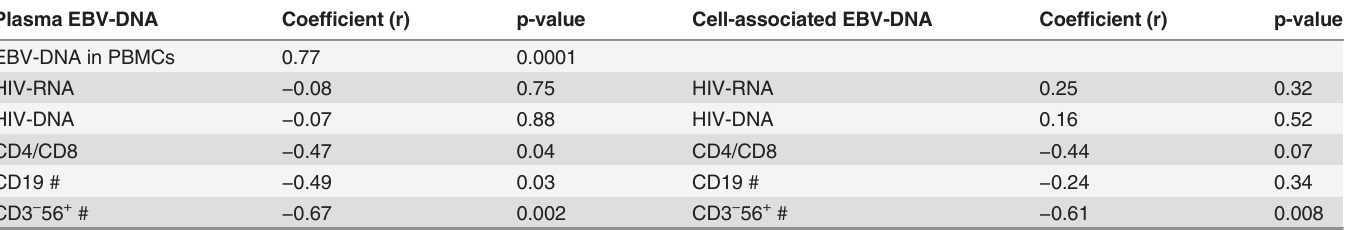
Table 2. Spearman ’ s rank correlation coef fi cients between EBV-DNA levels in plasma or PBMCs compartment and virological or immunological parameters before debulking chemotherapy. Plasma